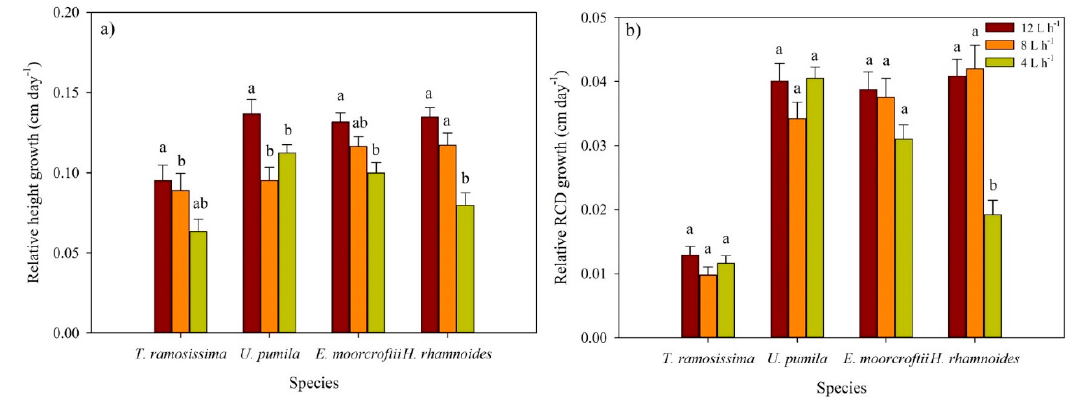
Figure 5. ( a ) Relative height growth rate (cm day − 1 ) and ( b ) relative root collar diameter growth rate (cm day − 1 ) of Tamarix ramosissima , Ulmus pumila , Elaeagnus moorcroftii , and Hippophae rhamnoides across different irrigation treatments (12, 8, 4 L h − 1 ) measured from the period of 2009–2019 growing seasons. Different lowercase letters within each species indicate significant differences among the treatments at α = 0.05. Vertical bars represent standard errors.